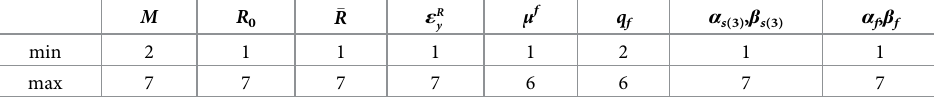
Table 4. Minimum and maximum phases in which parameters were first activated for the 27 best (out of 100 total) replicate randomizations of cfg XVI. All negative log-likelihoods were 11,391, as reported in Table 3 (the other replicates of cfg XVI had negative log-likelihoods from 11,393 to